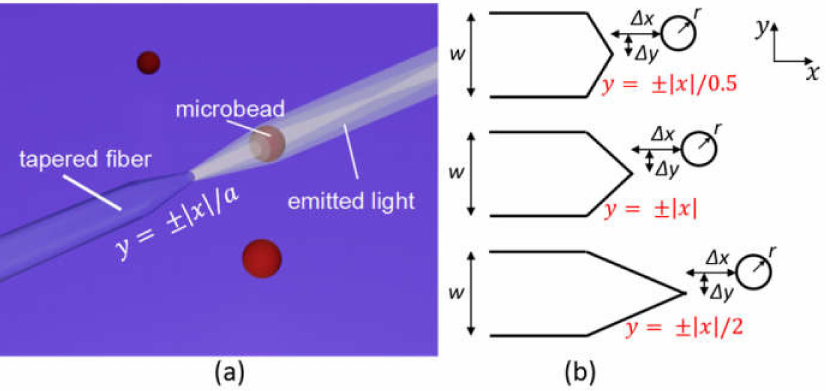
Figure 1. ( a ) The illustration of the axicon lensed fiber immersed in water and defined by a linear equation y = ± | x |/ a ; ( b ) the side view of the linearly tapered fiber with a = 0.5, 1, and 2,